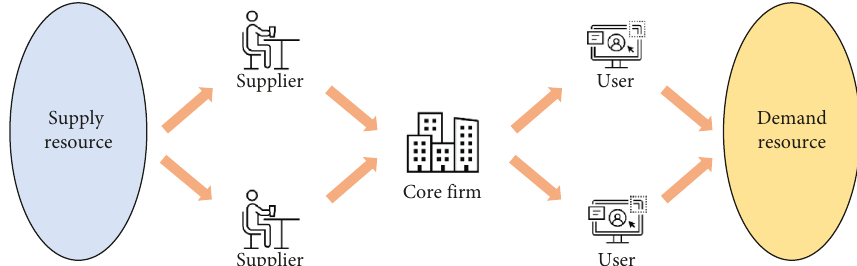
Figure 4: Structure of industrial logistics system based on supply chain management.